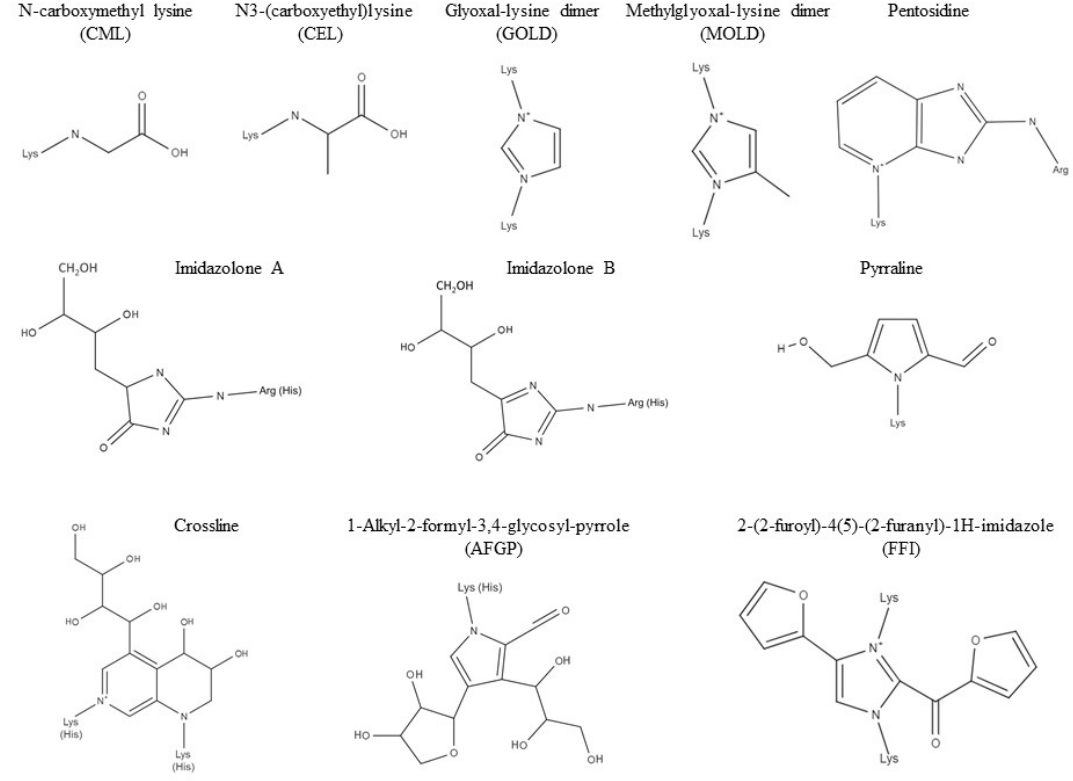
Figure 1. Chemical structures of biologically relevant advanced glycation end-products (AGEs). Lysine (Lys), arginine (Arg), and histidine (His) involved in the crosslinking are shown.